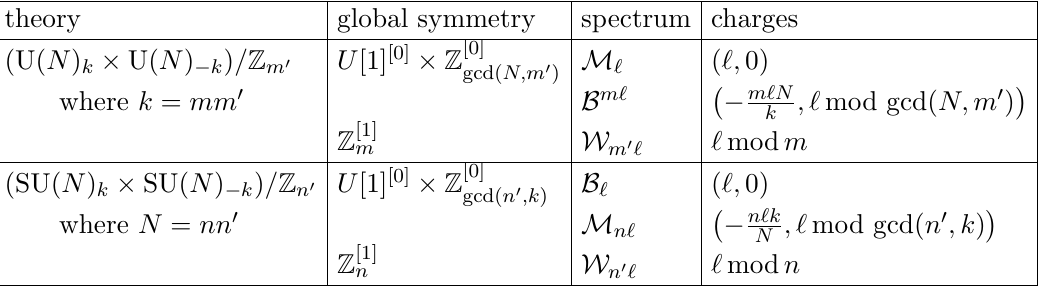
= 6 SCS theories. N